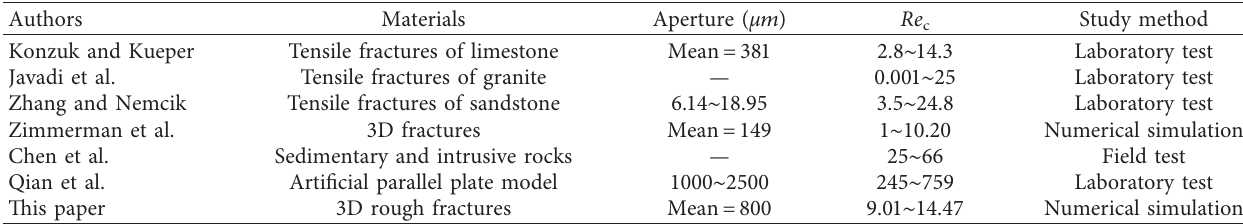
Table 2: Literature summaries about critical Reynolds number of flow in rock